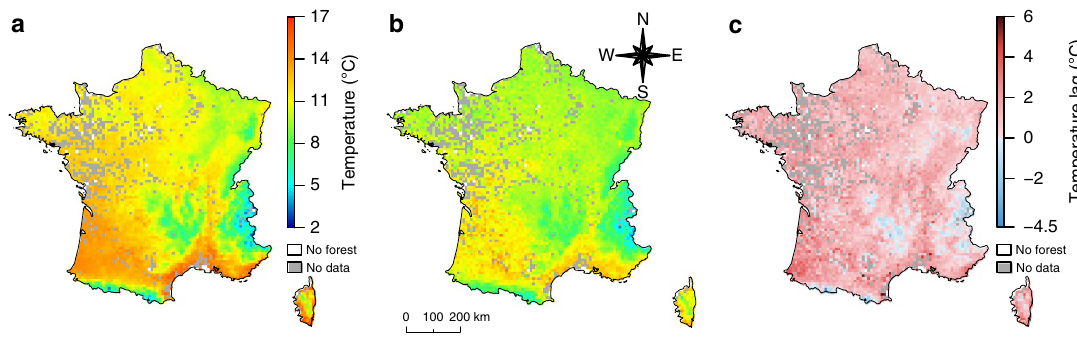
Figure 4 | Comparison of the spatial distributions of the observed and bioindicated temperatures. ( a ) Map of the baseline temperature conditions ( CrT ). ( b ) Map of the bioindicated temperatures from the forest herbaceous plant communities ( FrT ). ( c ) Map of the observed lag of temperatures between CrT and FrT ( dT ). The dT variable is computed as the difference between CrT and FrT in such a way that positive values represent climatic debts in plant communities. The maps show average values in a 10km grid computed from the 5,000 subsamples used to fit the PLS0 model. The temperature values mapped in a , b range from 2 to 17 (cid:2) C across France and is materialized by a colour gradient ranging from blue to red (a detailed colour scale is provided to the right of a ). The dT values mapped in c range from (cid:2) 4.5 to 6 (cid:2) C and is materialized by a colour gradient ranging from blue to red (a detailed colour scale is provided to the right of c ). White and grey pixels are areas without forest territory and without floristic survey, respectively. The map of the s.d. of dT is provided in Supplementary Fig.